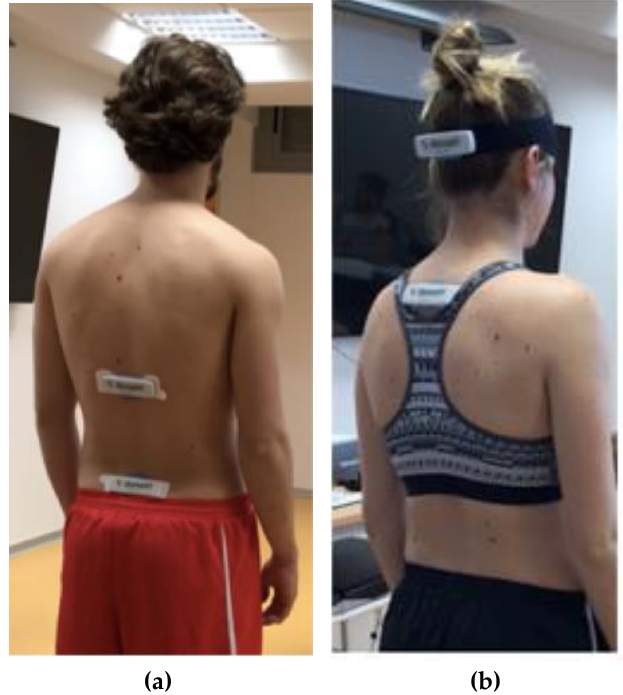
Figure 2. Range of motion (ROM) assessment with inertial motion units (IMUs). ( a ) Lumbar assessment. Subject position and device location. ( b ) Cervical assessment. Subject position and device location.